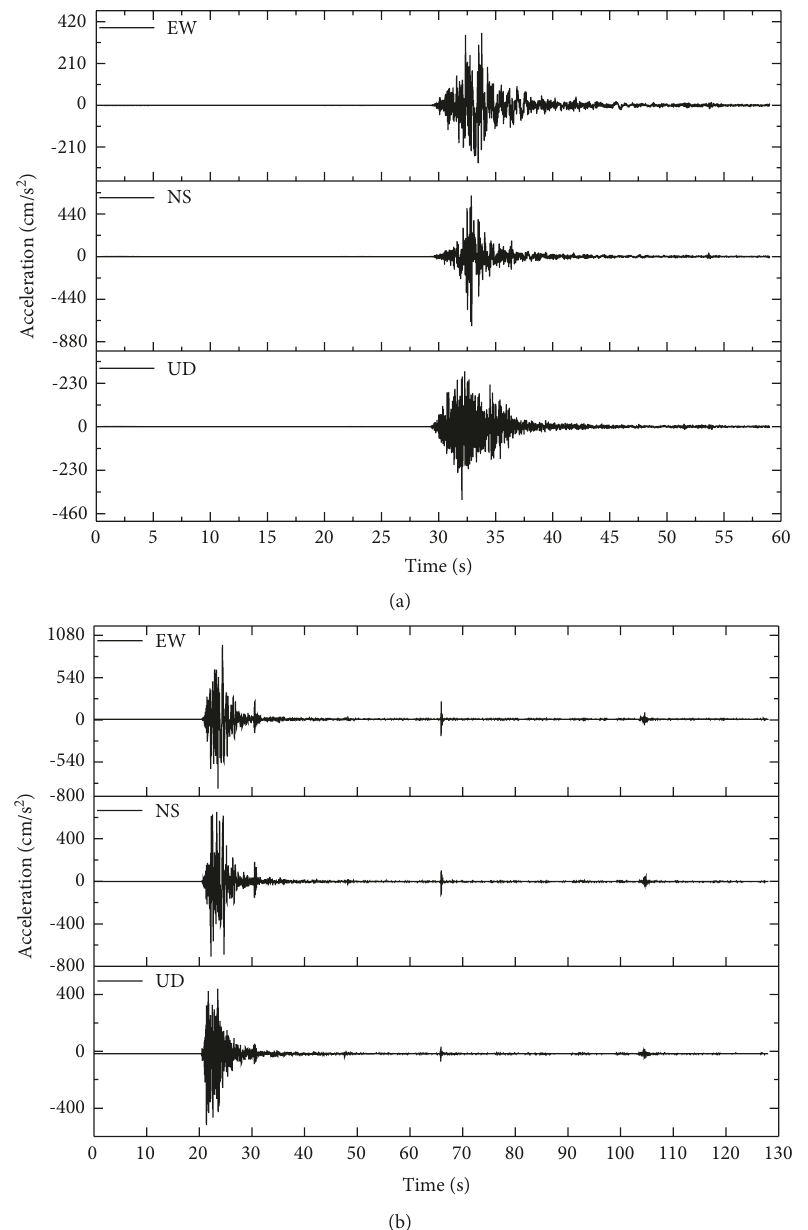
Figure 10: Acceleration time history of (a) 53YBX and (b)